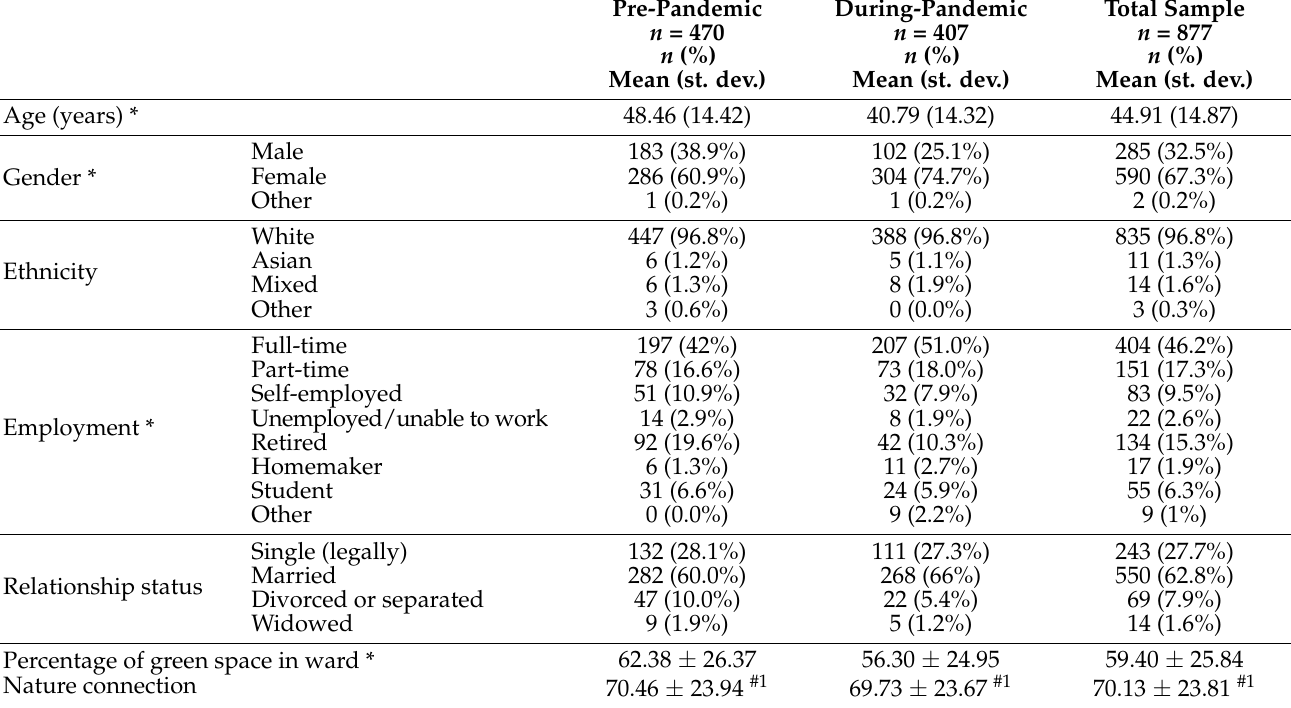
Table 1. Demographic information of participants.